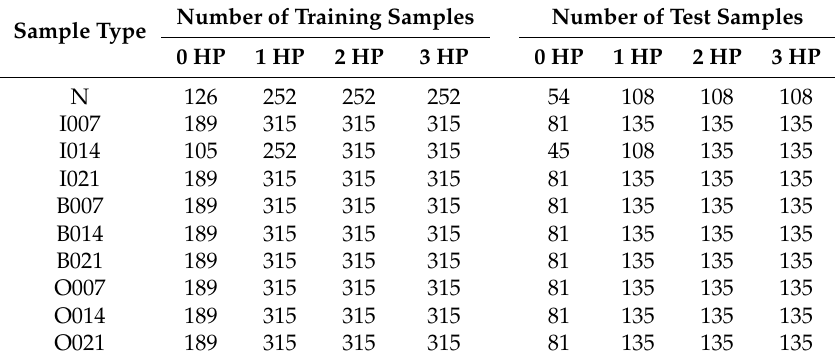
Table 2. Division of dataset composed of gray